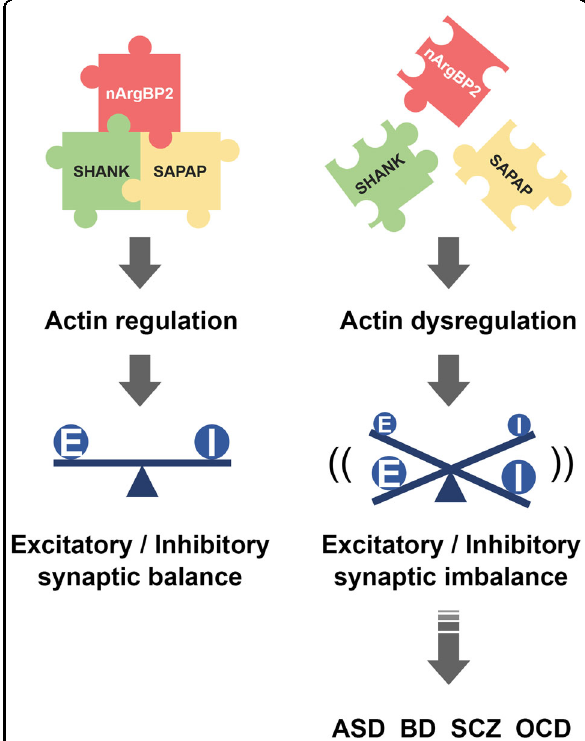
Fig. 3 Hypothetical model proposing the postsynaptic triad of nArgBP2-SAPAP-SHANK as a convergent pathway of psychiatric disorders. nArgBP2, SAPAP, and SHANK interact with each other, forming a structural and functional postsynaptic scaffold. They also organize multiple interactomes to regulate the actin cytoskeleton. Alterations in the expression of either one or more of the proteins participating in the core triad would break the interactome balance and induce actin cytoskeleton dysregulation, leading to abnormal spine formation and morphogenesis, which consequently undermines excitatory synapse formation. Depending on levels of expression or activity of this core triad in a speci fi c brain region, diverse levels of E/I imbalance may lead to the numerous phenotypes of psychiatric disorders. Thus, actin regulation by the core triad in dendritic spines is a convergent mechanism for various psychiatric disorders such as ASD, BD, OCD, and